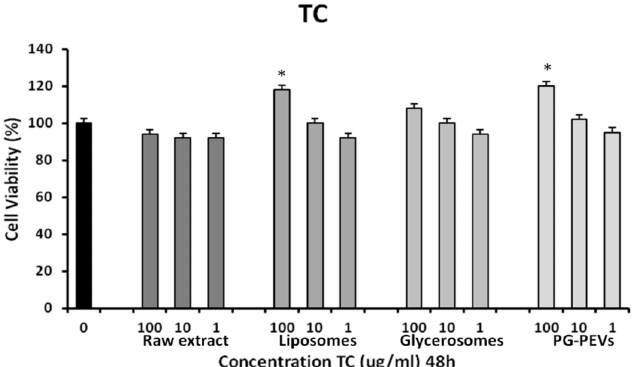
Figure 1. MTT assay after 48 h exposure to di ff erent concentrations (100, 10, 1 µ g / mL) of TC essential oil, TC liposomes, TC glycerosomes, and TC PG-PEVs. ANOVA analysis showed high significance values (* p < 0.001) for liposomes and PG-PEVs at 100 µ g / mL vs. the untreated control (0; 100%